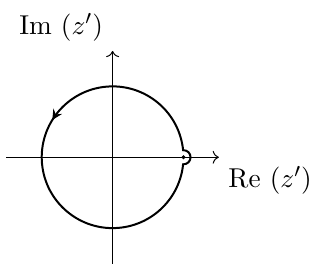
Figure 2 . Integration contour γ − in z -plane. Pole at z = 1 is excluded.